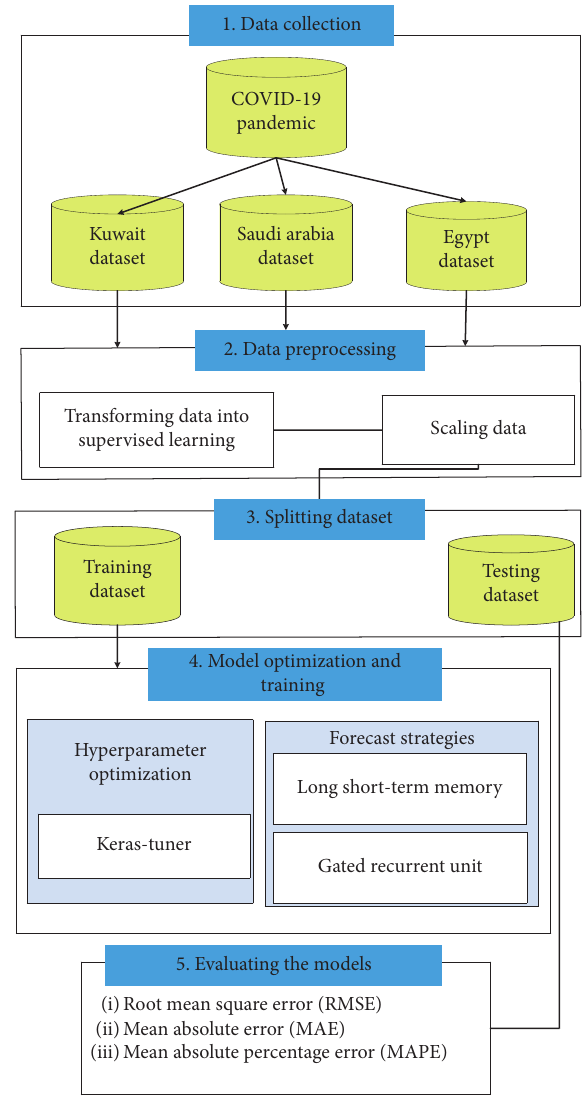
Figure 1: Architecture of the proposed system for forecasting